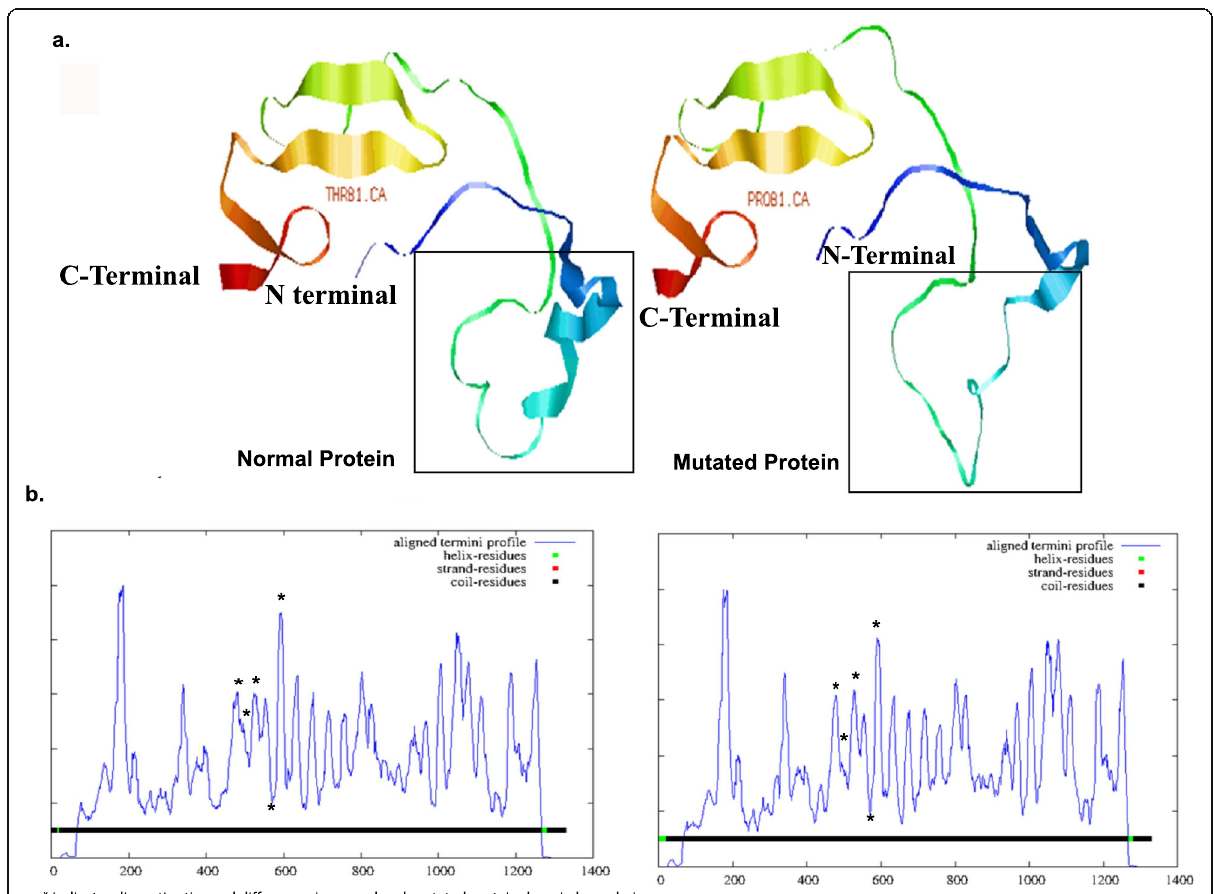
Fig. 4 a Protein modeling for normal and mutated CNTNAP2 protein product with marked mutation and conformational change highlighted in a box. The mutated protein structure was rendered as non-functional with reduced stability and depth and increased solvent accessibility. b Domain boundary prediction to understand the changes in residues and aligned termini profile. The coil residue have undergone multiple changes highlighted with an asterisk in the graph across normal and mutated protein leading to disorder and